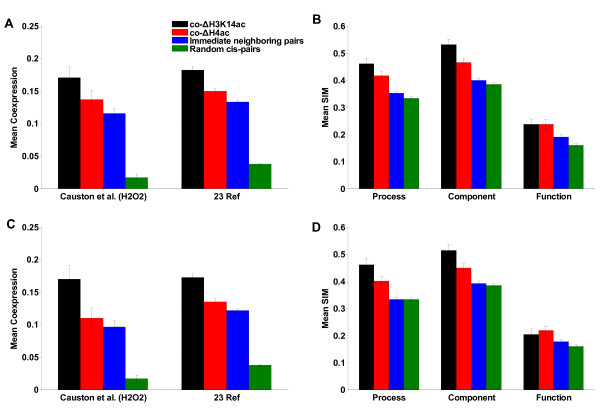
Mean coexpression and mean functional similarity of gene pairs in coacetylation domains. (A) Mean coexpression of gene pairs in co-ΔH3K14ac domains (black) and in co-ΔH4ac domains (red), immediate neighboring gene pairs (blue) and 10,000 random cis-pairs (green). The left-hand side is coexpression in H2O2-stress condition, and the right-hand side is the mean coexpression of data sets from 23 different references. (B) Mean semantic similarity (SIM) in Gene Ontology. (C) and (D) Mean coexpression and mean SIM of gene pairs by excluding the divergent pairs and pairs with the same TFBS.